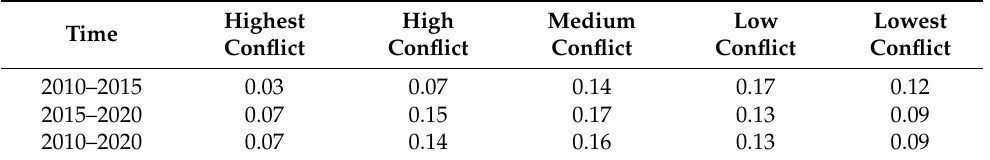
Table 5. Random forest accuracy by RMSE.